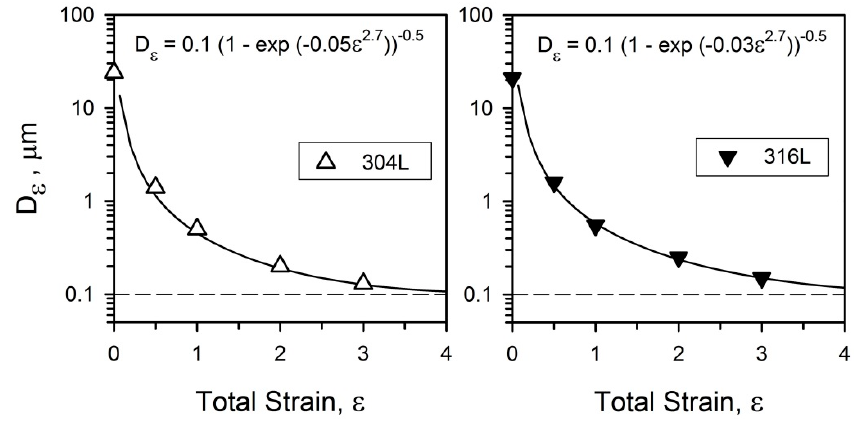
Figure 13. The effect of rolling at 473 K on the mean grain size (D ε ) in 304L and 316L stainless steels.